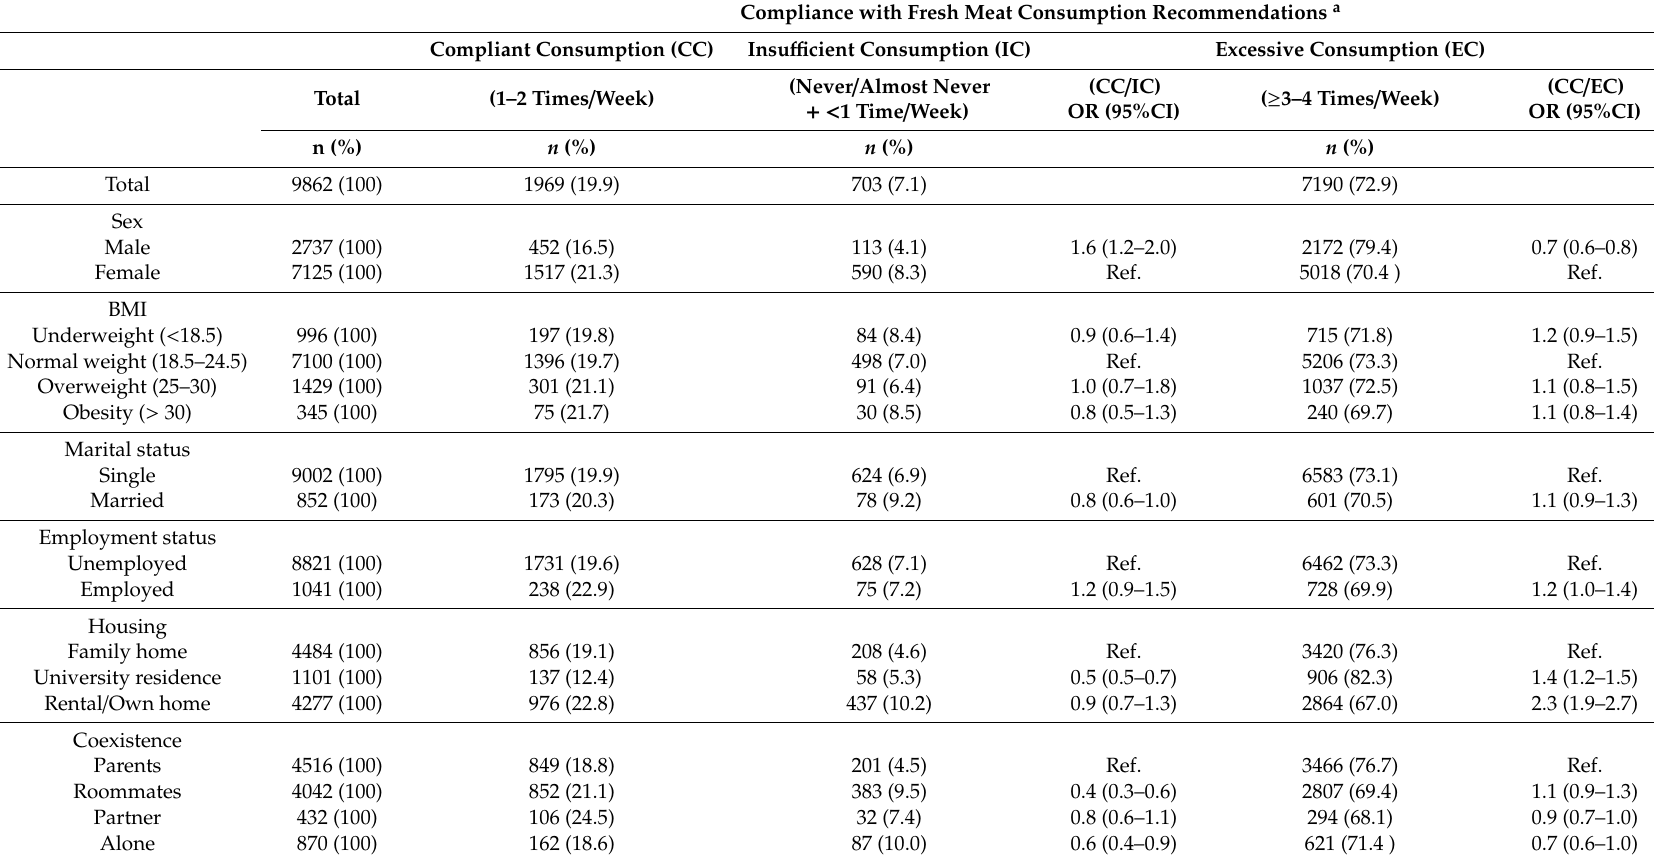
Table 4. Level of and factors associated with compliance with recommendations on the frequency of fresh meat consumption according to personal and sociodemographic characteristics of the university